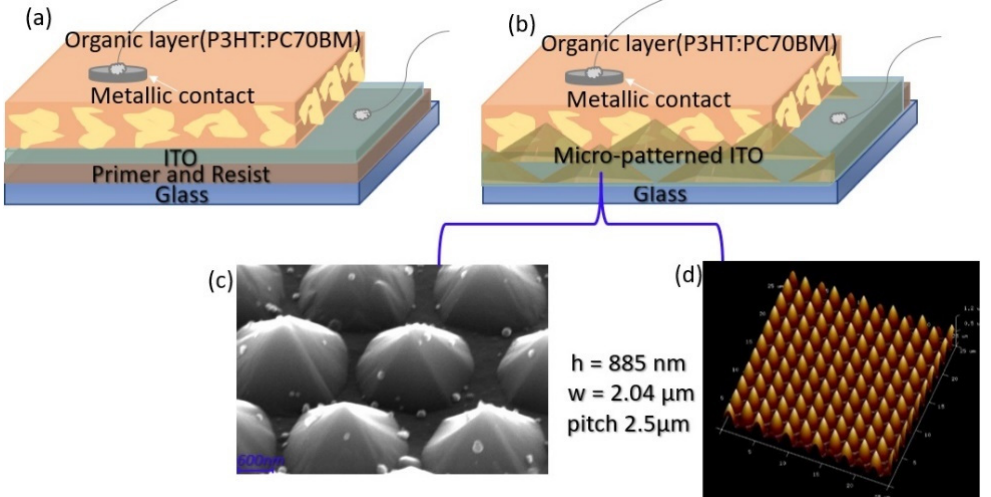
Figure 1. Schematic representation of the photovoltaic cell structures developed on ( a ) flat and ( b ) micro-patterned ITO electrodes, with ( c ) SEM and ( d ) AFM micrograph on 25 × 25 μm area, showing details of the imprinted pyramids characteristics.